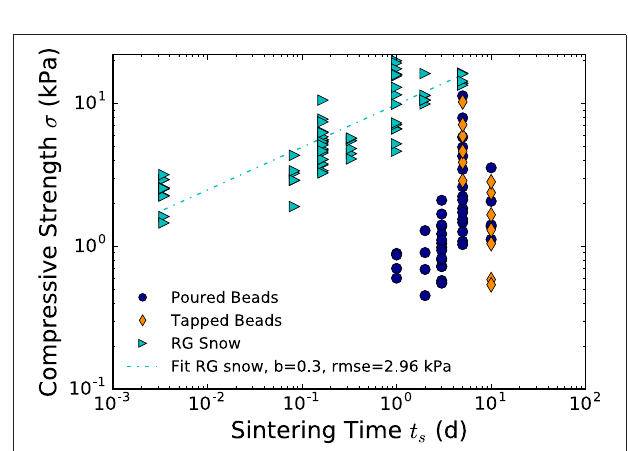
FIGURE 9 | The compressive strength of nature identical snow increases monotonously with sintering time, a power-law fit could be performed. For the ice beads, an increasing strength can only be observed up to 5 days. The 10-days-samples are weaker for both sample types.